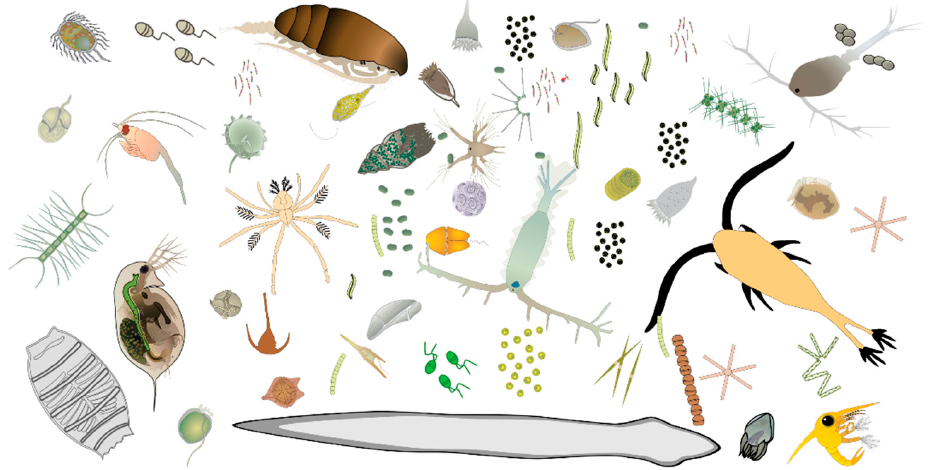
Figure 1. Scheme of planktonic organisms. Drawings based on the open-source IAN symbol library (https://ian.umces.edu/media-library/symbols/, accessed on 1 November 2021).